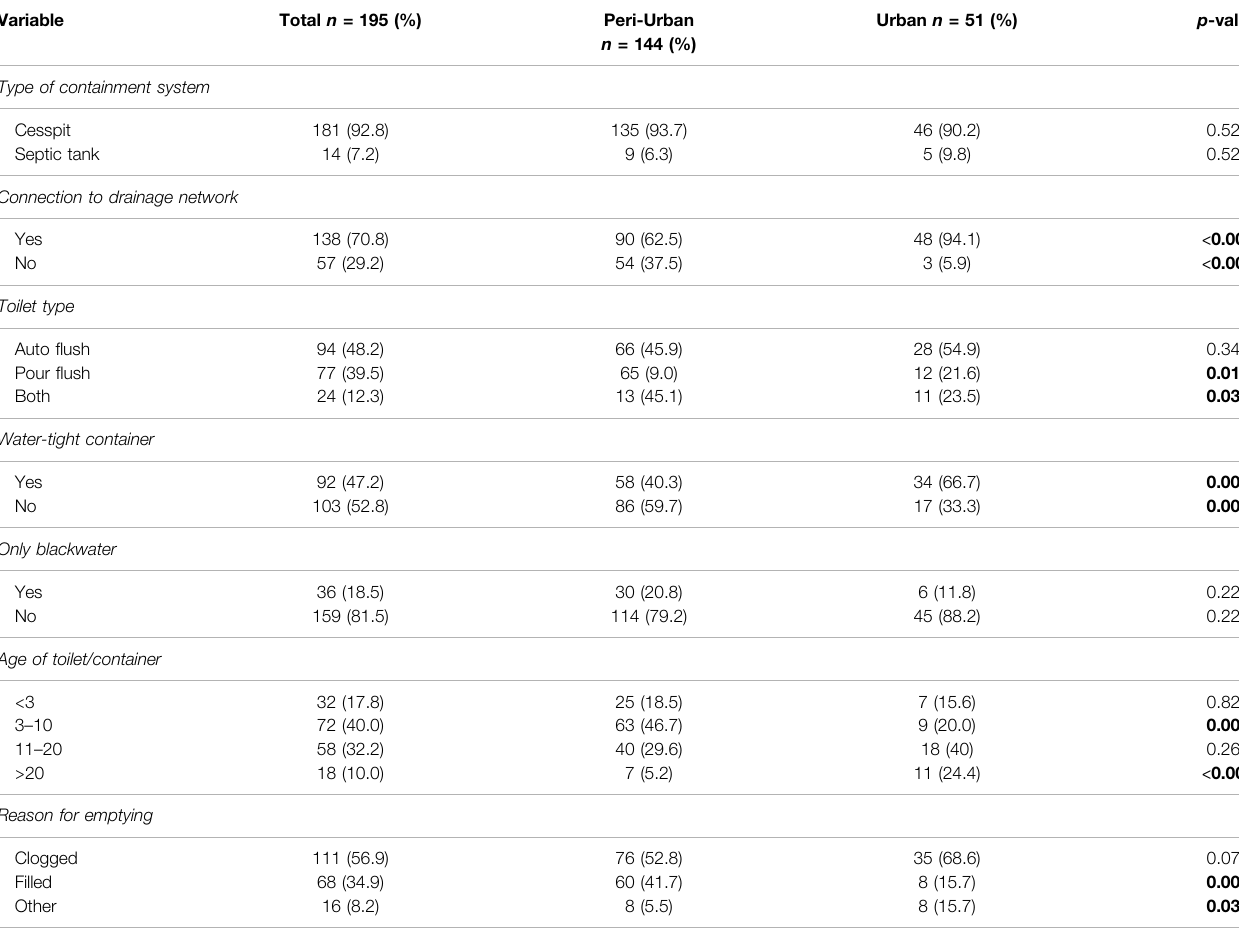
TABLE 1 | Sanitation management practices employed by responding households in peri-urban and urban areas of Phnom Penh. Values in brackets are percentage of the respective total. Values in bold indicate signi fi cant difference between peri-urban and urban settings ( p < 0.05).